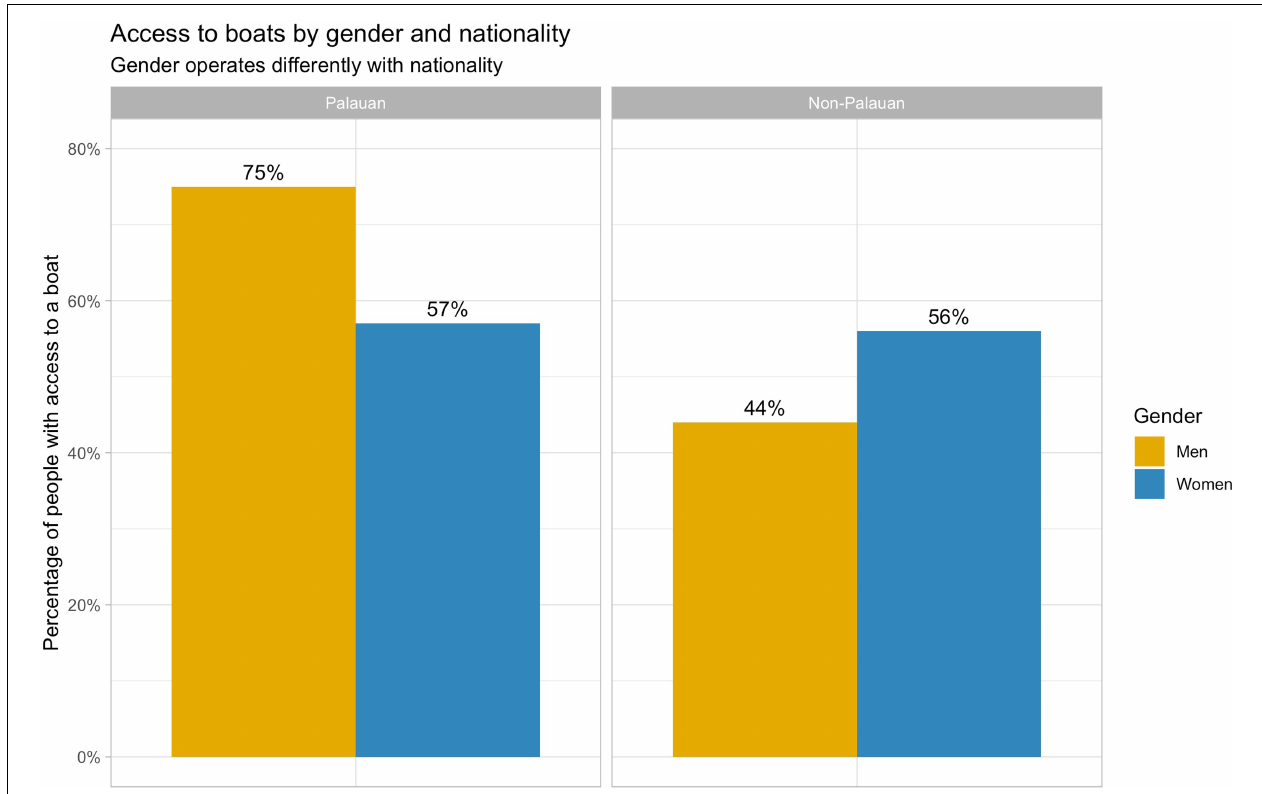
FIGURE 4 | Gender operates differently depending on a harvester’s nationality, with immigrant women having greater access to boats than immigrant